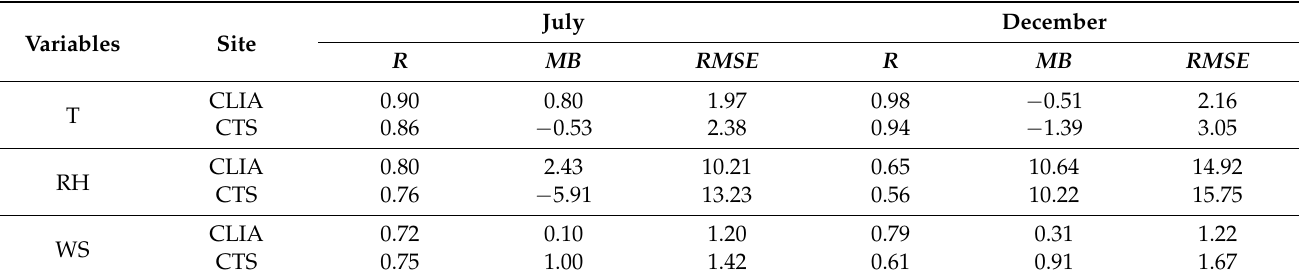
Table 4. Statistical metrics of hourly temperature (T), relative humidity (RH) and wind speed (WS) in July and December of 2021 at two sites of Changchun, northeast